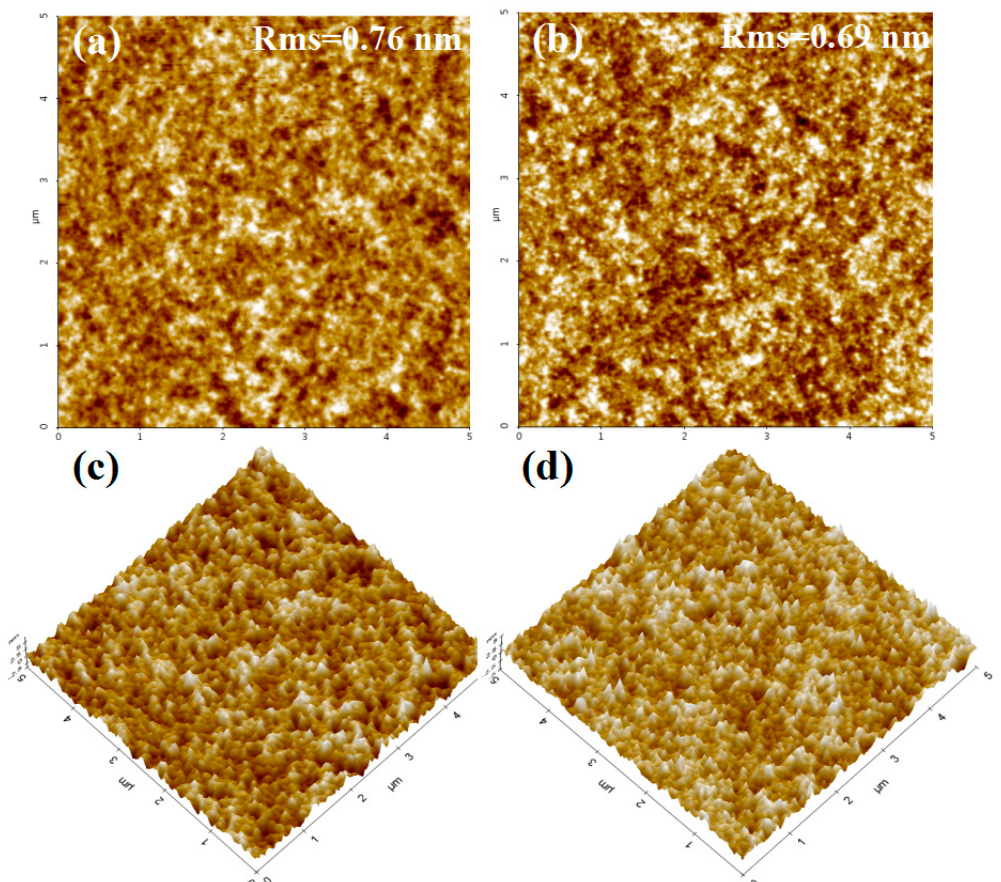
Figure 4. 2D morphology images of ( a ) the PEDOT:PSS and ( b ) PEDOT:PSS-ET ( v / v , 1:0.5) films, and 3D morphology images of ( c ) PEDOT:PSS and ( d ) PEDOT:PSS-ET ( v / v , 1:0.5) films obtained with AFM at a scale of 0.5 μ m × 0.5 μ m.